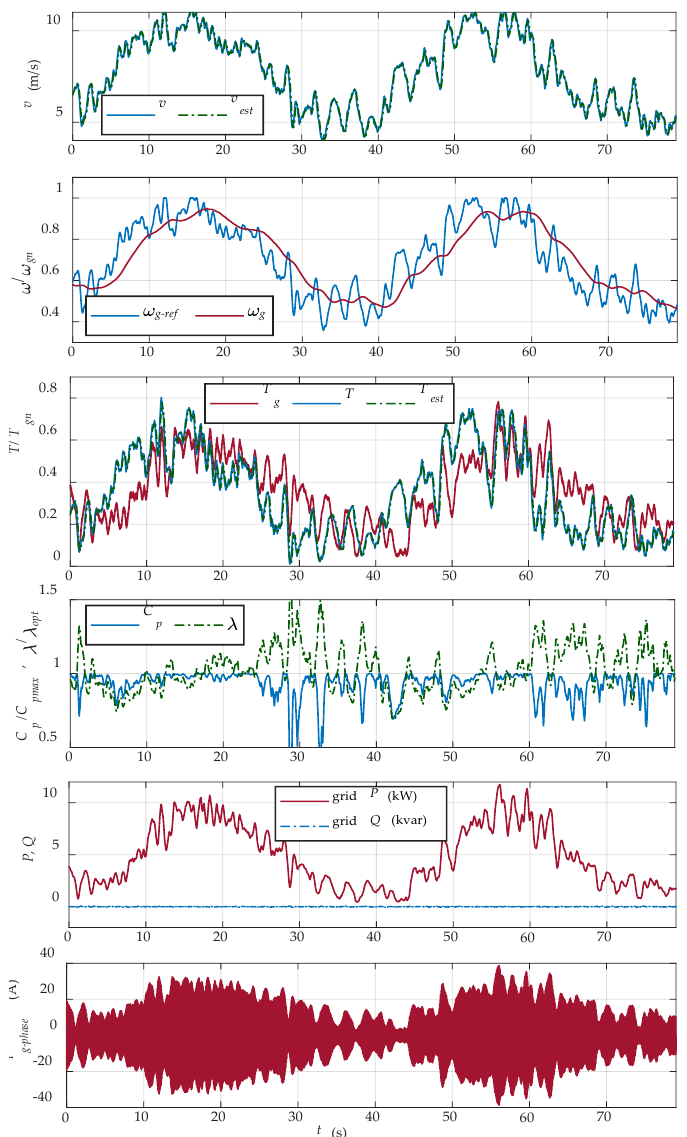
Figure 11. Plots of the WECS variables for the wind speed profile with slowly varying sine components and superimposed random noise, described by Formula (21) .